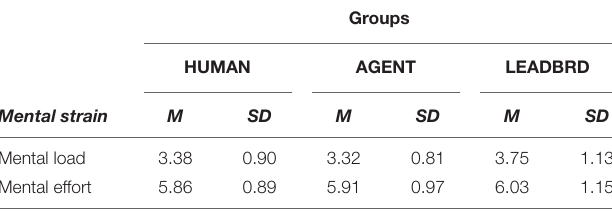
TABLE 3 | Mental strains within the groups.